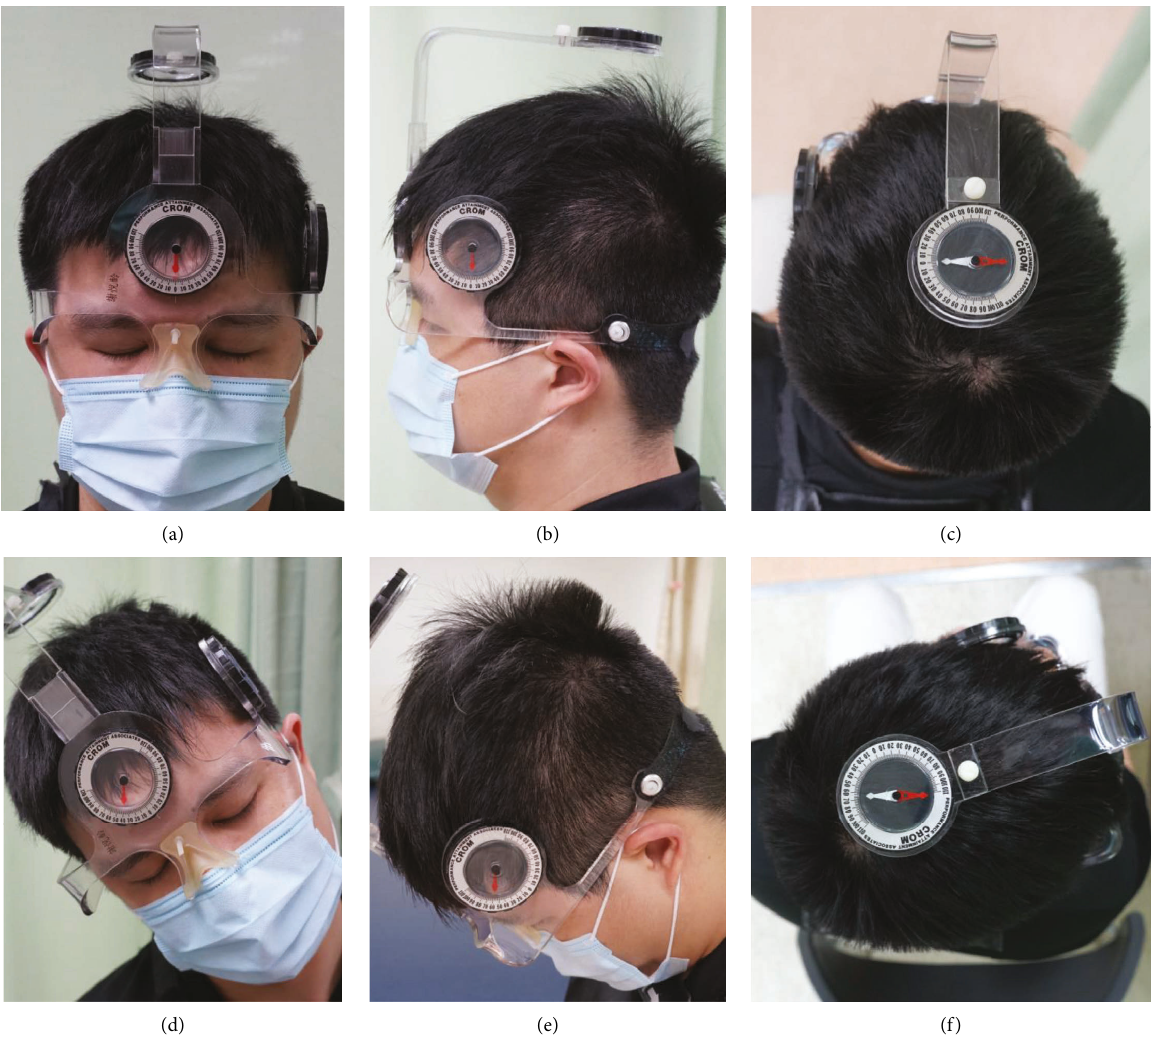
Figure 5: Neck range of motion assessment. Participants were asked to wear the Cervical Range of Motion (CROM) instrument. Zeroing the gravity inclinometer at the front (a), at the lateral (b), and on the top (c) of the device before assessment. The red arrow of three inclinometers indicated the angle of zero. The angle change was measured when participants did the action of neck movement, that is, right-side bending (d), flexion (e), and right rotation